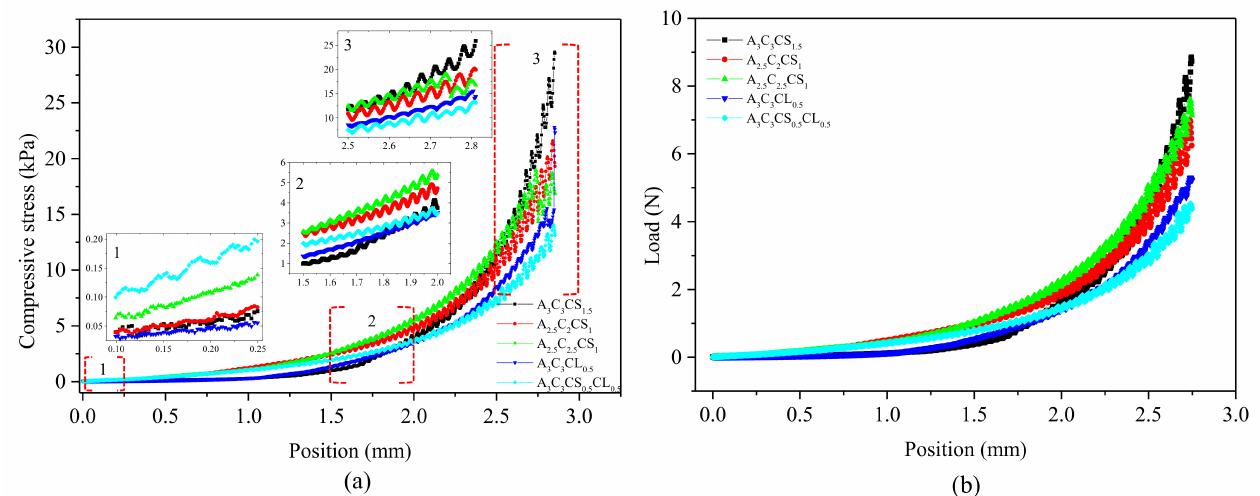
Figure 13. ( a ) Compressive stress and ( b ) Corresponding load with respect to the position change of the load cell. Each data point was calculated by averaging three sample points.